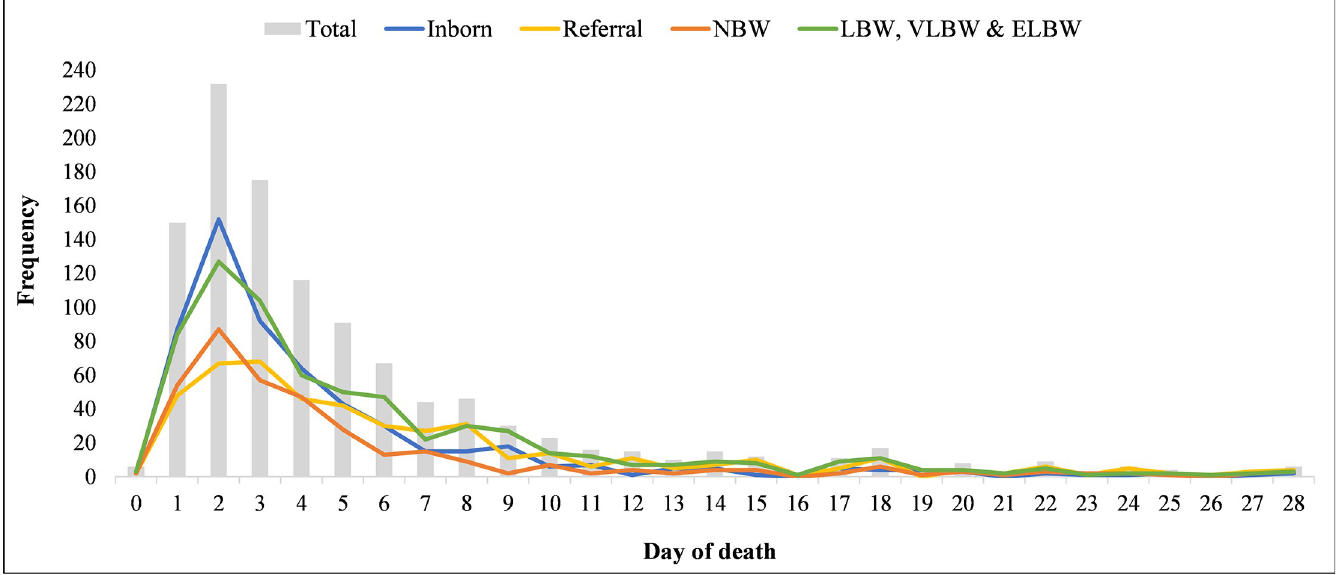
Fig 1. Frequency of neonatal mortality by neonatal age and stratified by referral and birth weight.